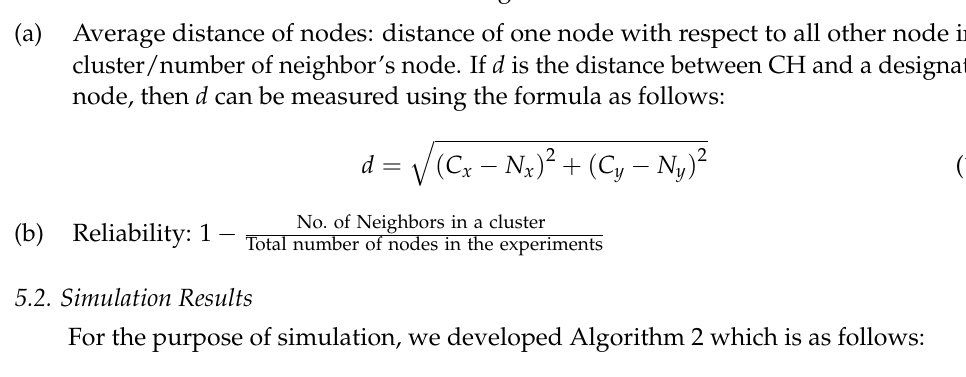
Algorithm 2 WSN Lifetime extension